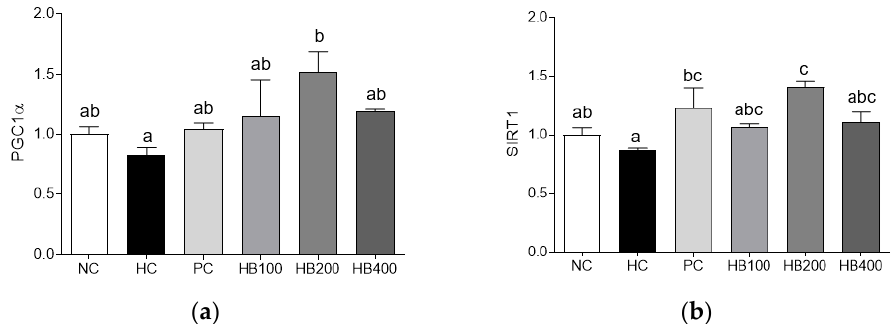
Figure 8. Effects of HB extract on mRNA expression of levels of muscle growth related genes in muscle tissues. ( a ) PGC1 α ; ( b ) SIRT1. Gene expressions were normalized to that of 18S rRNA. NC, Normal diet Control; HC, HF diet control; PC, HF diet with orlistat at 20 mg/kg; HB100, HF diet with honeysuckle berry extract at 100 mg/kg; HB200, HF diet with honeysuckle berry extract at 200 mg/kg; HB400, HF diet with honeysuckle berry extract at 400 mg/kg. Data are presented as mean ± SD ( n = 8). Different letters indicate significant differences by one-way ANOVA ( p < 0.05) followed by Duncan’s multiple range tests.